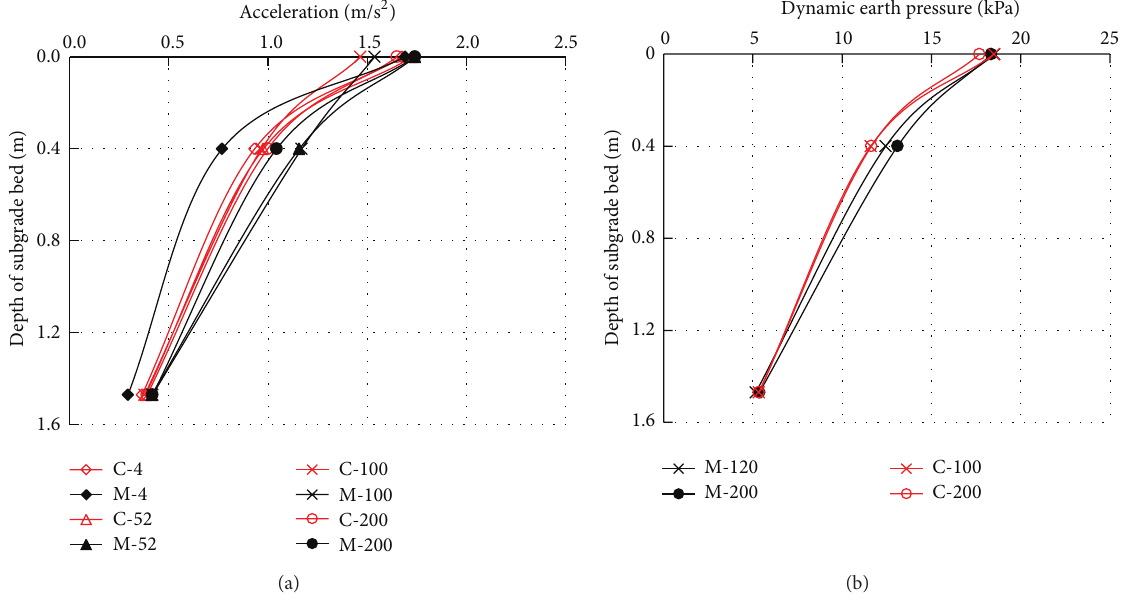
Figure 16: Distribution of vertical acceleration (a) and dynamic soil pressure (b) of the low subgrade under vibration loading along